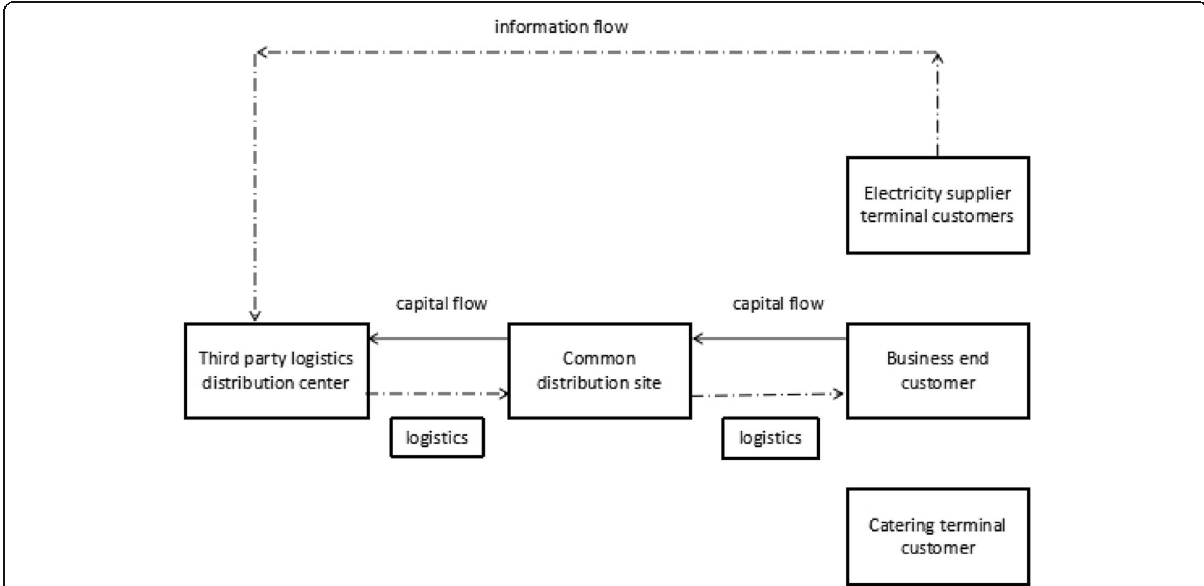
Fig. 1 Dendrogram of double-layer distribution structure. Joint distribution is a collection of goods by third-party logistics enterprises; enterprises or businesses will transfer the goods to the transporters. Then the goods will be transported by the transporters to the local customers. This is a kind of distribution mode dominated by the third-party logistics company, because the third-party logistics company has the specialized operation level and the management experience; at the same time, it can serve for many enterprises, so it can deal with the adverse influence of the fluctuation of the business volume. It mainly includes logistics, information flow, and capital flow. Logistics flows from third-party logistics distribution center to terminal